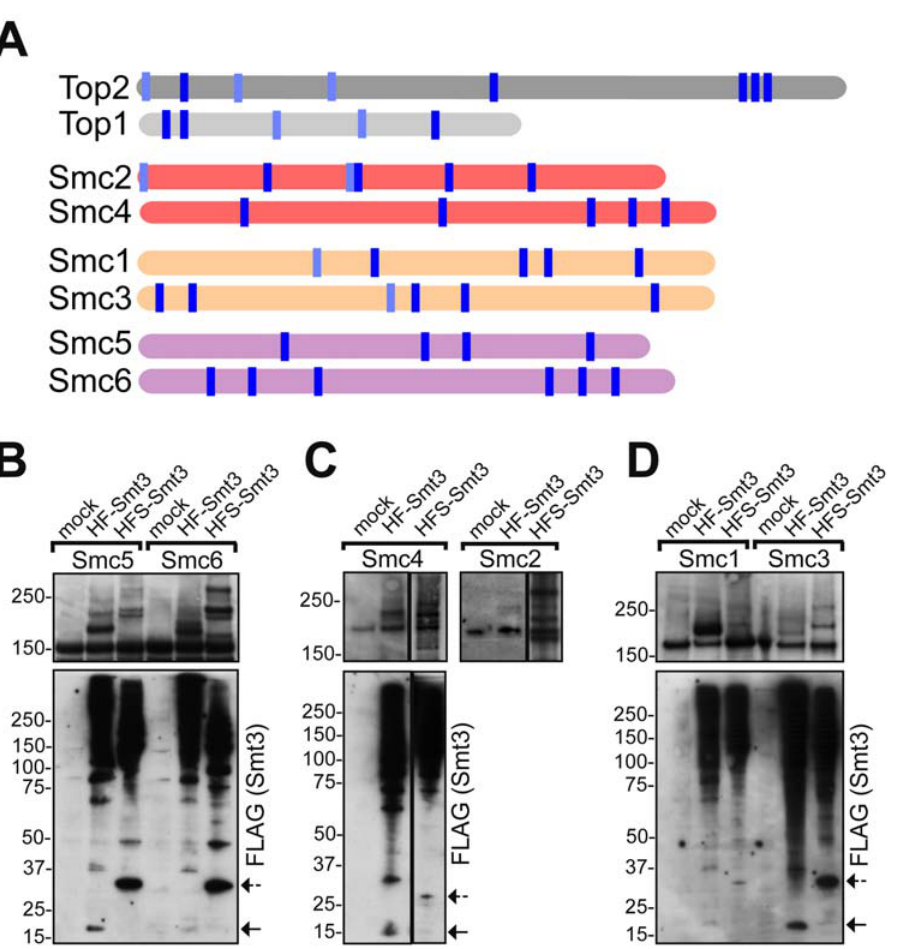
Figure 4. SMC proteins are sumoylated. (A) Predicted sumoylation sites in topoisomerases and SMC proteins. Sumoylation sites were predicted with the SUMOplot TM algorithm (Abgent). Vertical blue lines indicate the positions of potential sumoylation sites: dark - a high score for predicted sites ( . 0.9), light - lower scores (0.8–0.9). (B–D) SUMO modifications of the six SMC protein complexes are revealed by differential Smt3p tagging. Each of the SMC proteins was tagged with 5xHA; strains also contained differentially tagged Smt3p as indicated. Cells were treated with nocodazole prior to conjugate purification by IMAC. The arrows indicate un-conjugated forms of tagged SUMO. Sumoylated SMC proteins were detected according to the principle in Figure 1A by anti-HA antibody, except for Smc2p (specific anti-Smc2